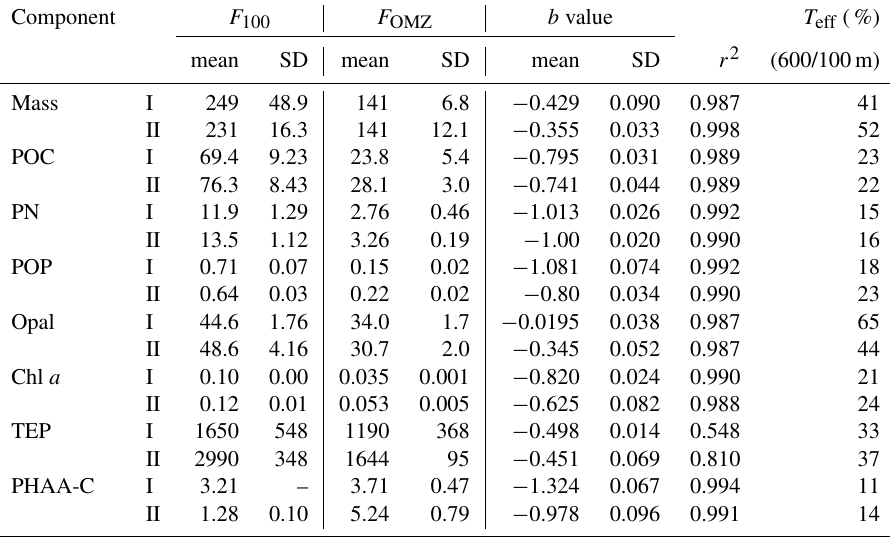
Table 1. Fluxes of particulate components at 100m depth ( F 100 ) and in the core of the OMZ at 400m ( F OMZ ) , as well as the associated attenuation coefficients ( b values) and transfer efficiencies ( T eff , %) over the depth range of 100 to 600m during two traps deployments in the ETNA. All units are in mgm − 2 d − 1 except for TEP fluxes, which is reported in total particle area cm − 2 m − 2 d − 1 . Mean values and standard deviations (SD) were calculated from analytical